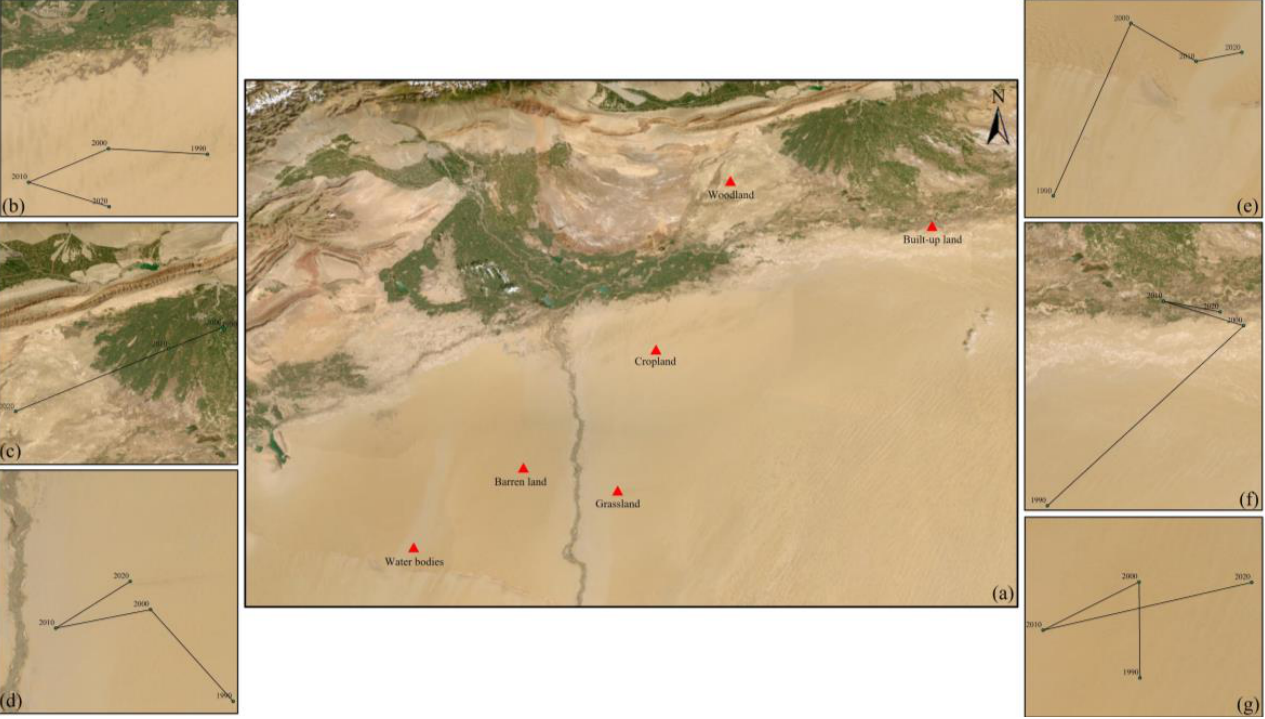
Figure 4. Migration of center of gravity of different land types in the Tarim River Basin from 1990 to 2020 (Figure ( a ) shows the center of gravity of each land type in 2020, and Figures ( b – g ) show the migration trajectories of the center of gravity of cropland, forest land, grassland, water bodies, built-up land, and unused land, respectively).